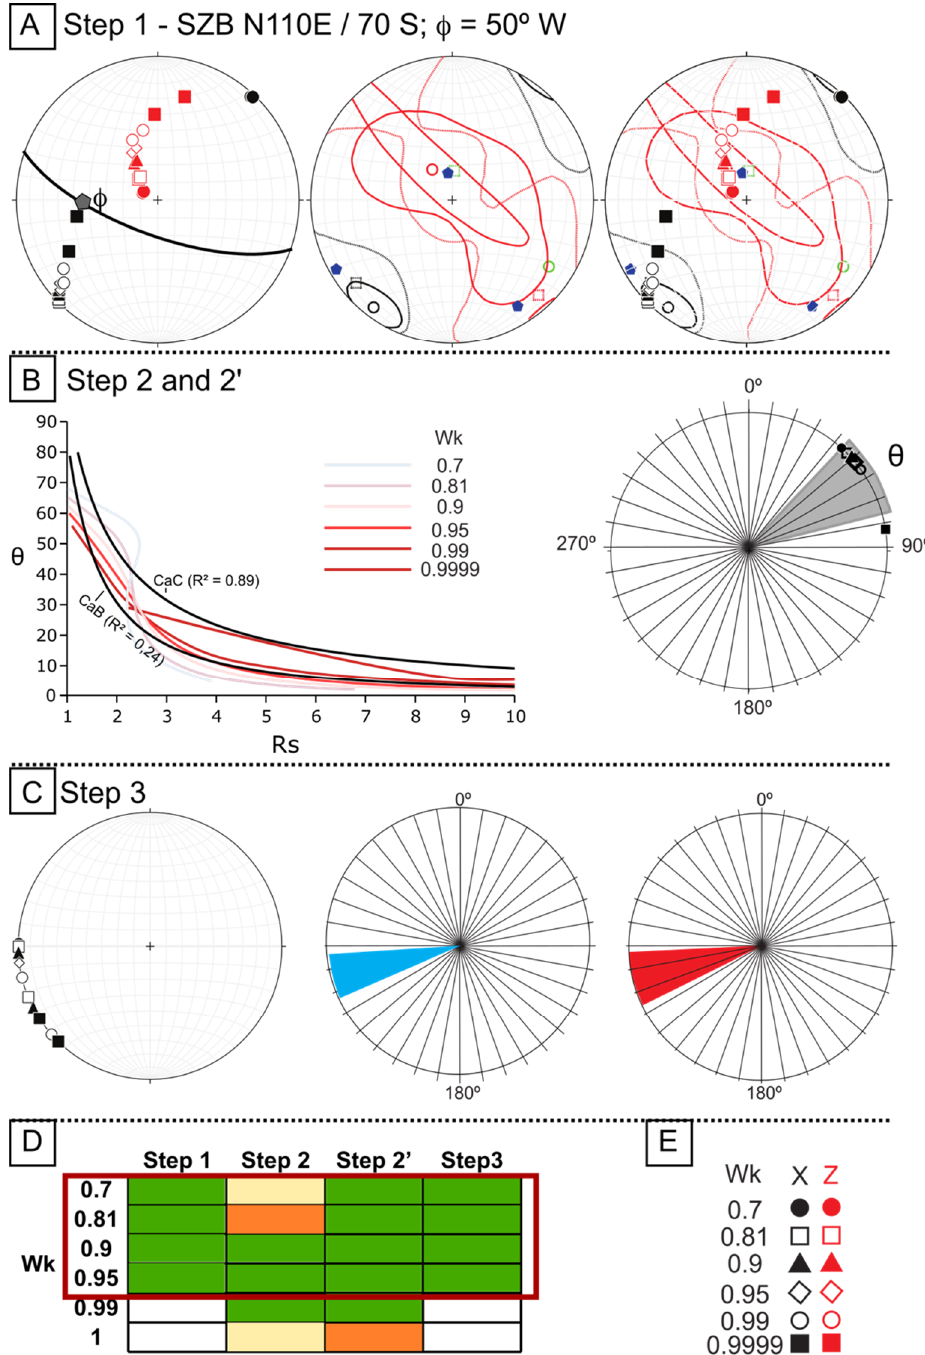
Figure 6. Example of the application of the transtensional model to the ESFZ using the orientation of the shear zone of N110 ◦ E and ϕ = 50 ◦ W. ( A ) Step 1 compares ( right diagram) the orientation of the principal axes of the measured incremental strain ellipsoids (X, Y, Z and their respective confidence cones, central diagram) with those resulting from the transpression model for various W k values (left diagram; black symbols: X axes; red symbols: Z axes) in equal area, lower hemisphere plots. ( B ) Step 2 represents the left shape (axial ratio, Rs) and orientation ( θ angle) of the sectional horizontal ellipse of the measured caldera (Caldera and Edifice Borders (CaB) and Carboneras Caldera (CaC) labeled black lines) against the predictions of the model for various Wk values (grey to purple lines); on the right, the projection of the maximum horizontal stretching axis measured by the GPS network (shaded in gray) against the predictions of the model (horizontal θ angle; symbols in black). ( C ) Step 3 compares the displacement of the bounding blocks predicted by the model for several Wk values and calculated by GPS (red and blue depending on the used data). ( D ) The bar